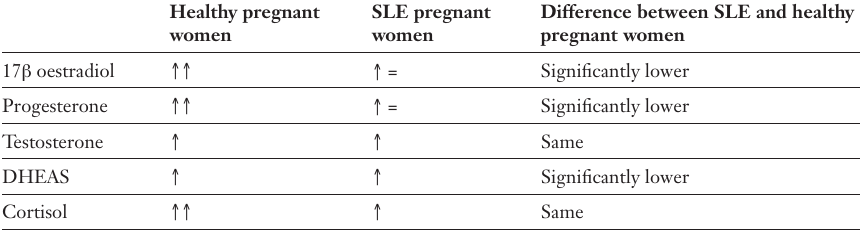
Table 1 Steroid hormone levels in healthy and SLE pregnant women in the third trimester of pregnancy compared to healthy non pregnant levels. The data refer to Doria et al. [9], Branch et al. [162], Shabanova et al.